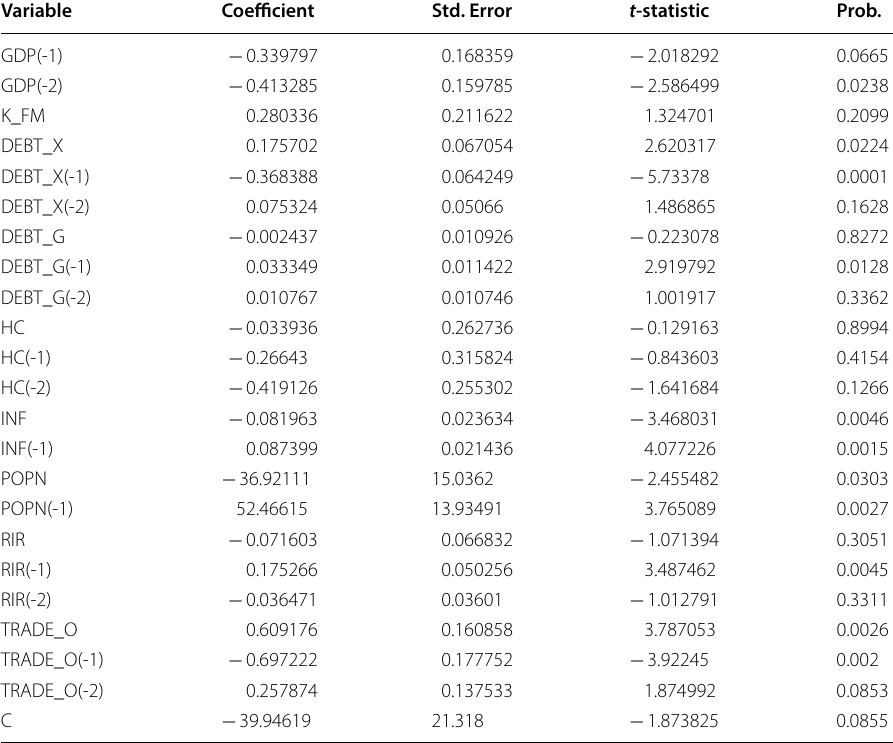
Table 5 ARDL estimation results for the effects of public debt on economic